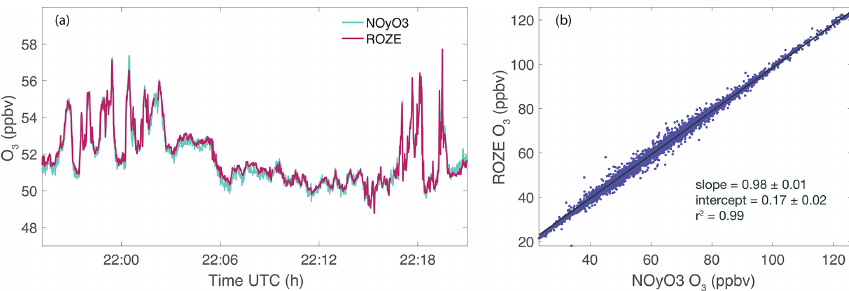
Figure 7. ROZE and NOyO3 measurements of O 3 from a FIREX-AQ flight on 30 July 2019 over the northwestern US. (a) Time series of ROZE and NOyO3 data (averaged to 1s). (b) Correlation plot of ROZE and NOyO3 O 3 measurements from the full flight. A linear fit to the data yields a slope of 0.98 ± 0.01 and an intercept of 0.17 ±